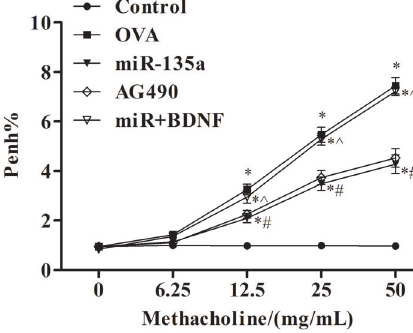
Figure 5. Effect of regulation of JAK/STAT signaling pathway on airway hyperresponsiveness (Penh%) in mice. Data are reported as means ± SD. *P o 0.05 compared to the control group; # P o 0.05 compared to the ovalbumin (OVA) group; ̂ P o 0.05 compared to the miR-135a group